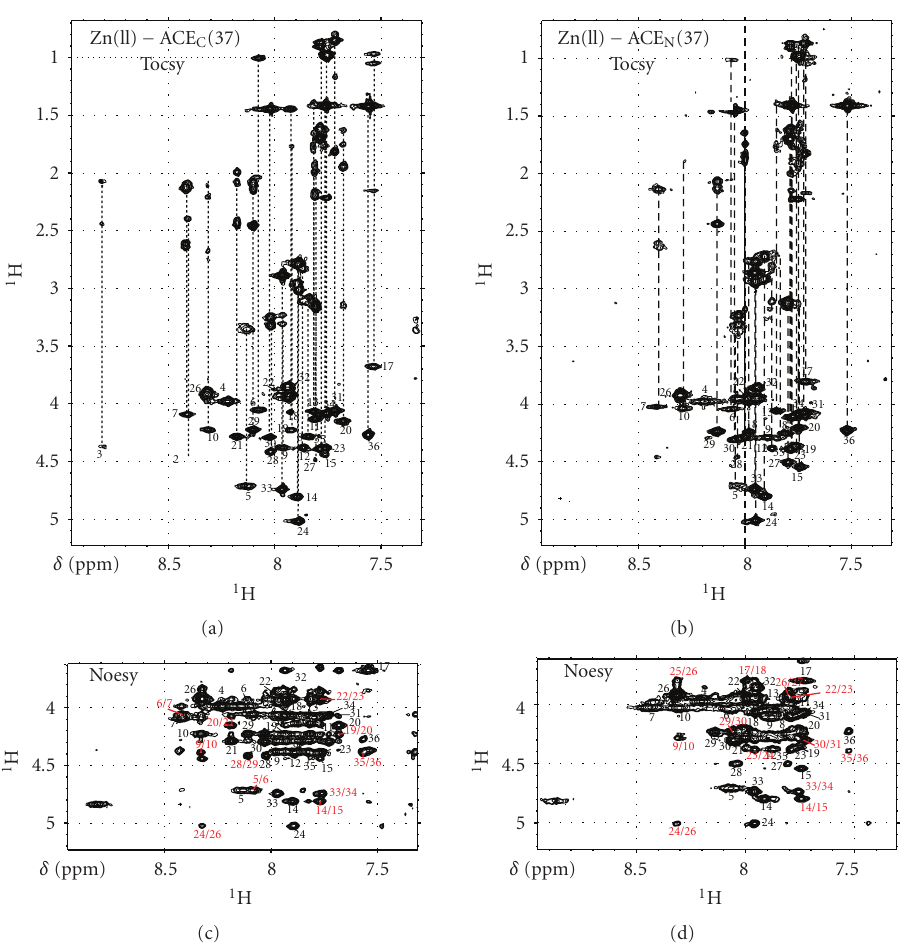
Figure 5: Fingerprint regions of 600 MHz TOCSY ((a) ACE C (37) and (b) ACE N (37)) and NOESY ((c) ACE C (37) and (d) ACE N (37)) spectra recorded at T = 298K. The sequential connectivity pattern shown indicates the peptide sequence-specific resonance